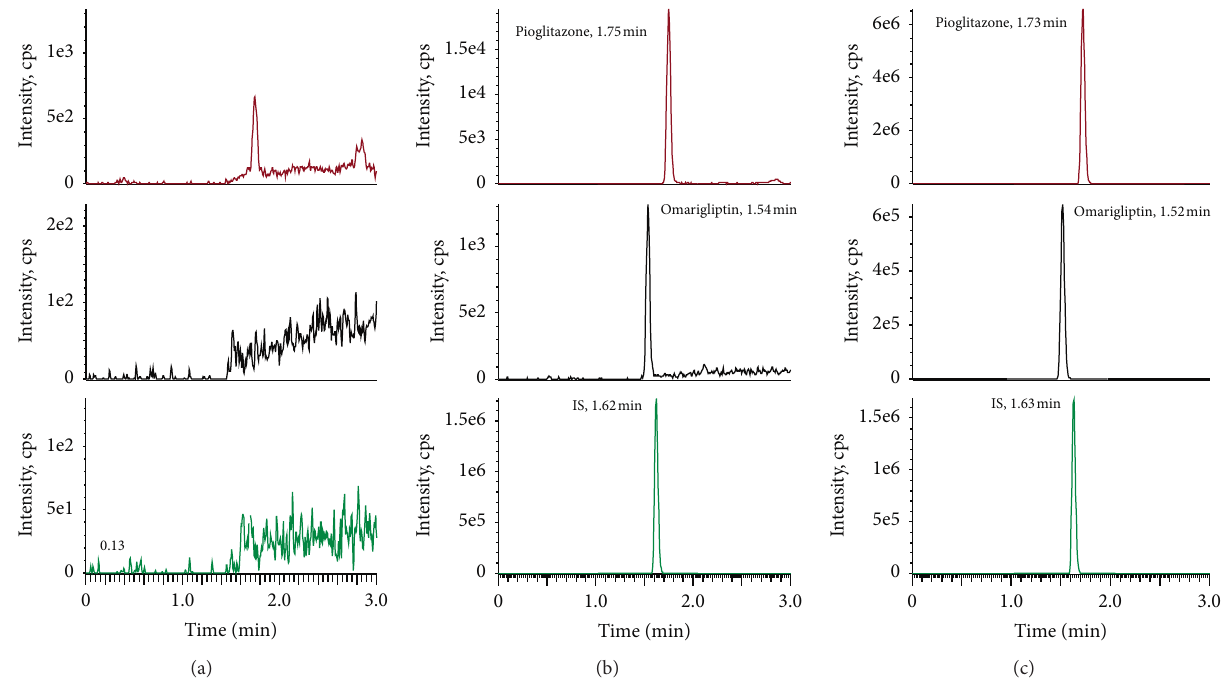
Figure 3: Representative MRM chromatograms for pioglitazone, omarigliptin, and IS from (a) blank rat plasma; (b) blank plasma spiked with pioglitazone (5ng/mL), omarigliptin (10ng/mL), and IS (50ng/mL); and (c) plasma from rats at 2h after oral administration of pioglitazone and